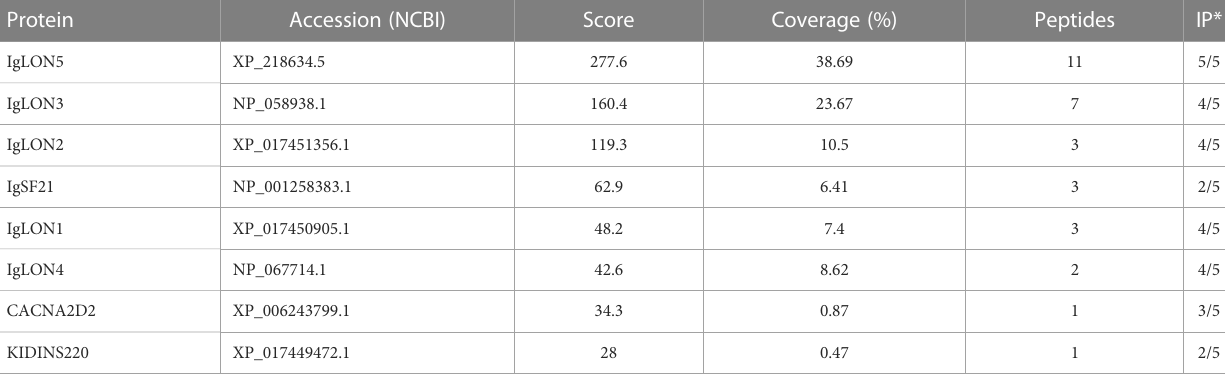
* Number of immunoprecipitations where the protein is identi fi ed. IgSF21: Immunoglobulin superfamily member 21 precursor; KIDINS220: Kinase D-interacting substrate of 220 kDa isoform X20; CACNA2D2: Voltage-dependent calcium channel subunit alpha-2/delta-2.